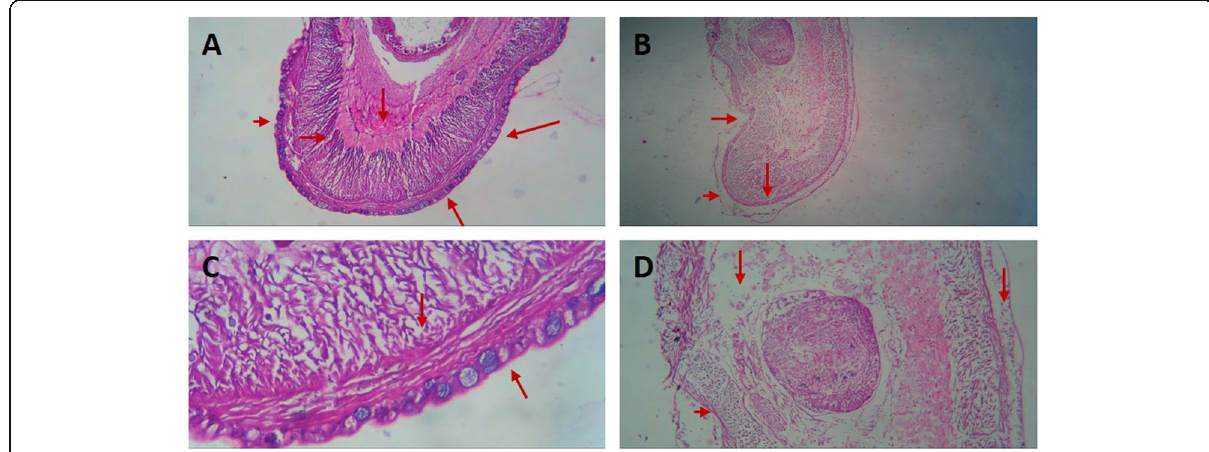
Fig. 9 Histological analysis of effect of extract upon Pheretima posthuma . a : Photomicrograph showing histology of normal subject (10x). b : Histology of treated subject (10x). c : Photomicrograph showing histology of normal subject (40 x), showing compactly arranged muscular bundle with proper connective tissues. d : Histology of treated subject (40x) indicating the muscular